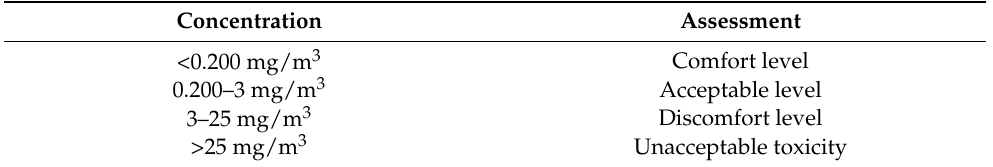
Table 3. Concentration level of VOCs and their assessment.